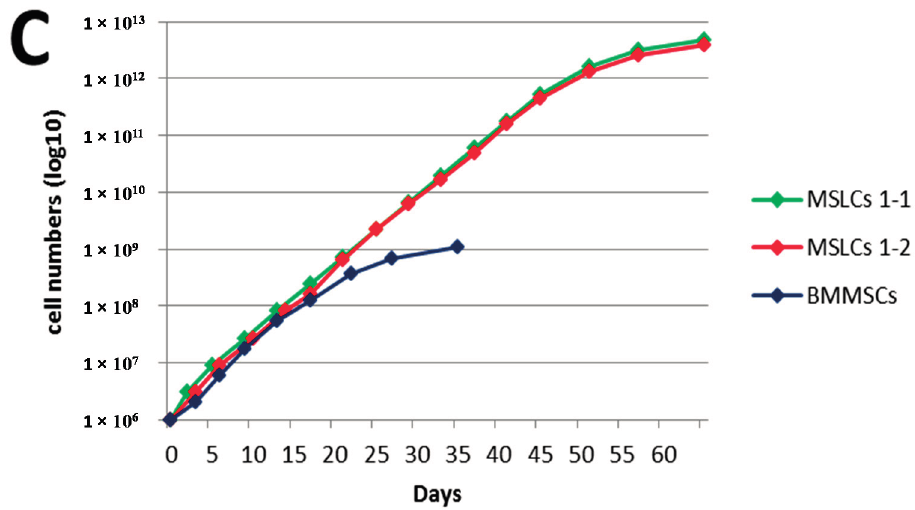
Figure 3. Characterization of MSC-like cells generated from iPSCs. ( A ) Morphology of HGF-iPSCs 1-1 at passage 45 cultured on GFRM with mTeSR1 ( left ). Morphology of MSC-like cells from HGF-iPSCs 1-1 differentiated (MSLCs 1-1) at passage 4 ( right ); ( B ) Flow cytometry analysis of MSC-related surface markers (CD44, CD73, CD90, and CD105), hematopoietic markers (CD34 and CD45), and pluripotent markers (SSEA3 and TRA1-60) on MSLCs 1-1 at passage 10. BMMSCs were used (passage 5) as positive control and HGF-iPSCs 1-1 (passage 45) as negative control; ( C ) MSC-like cells from HGF-iPSCs 1-2 (MSLCs 1-2) were differentiated at passage 23. Growth curve of BMMSCs,